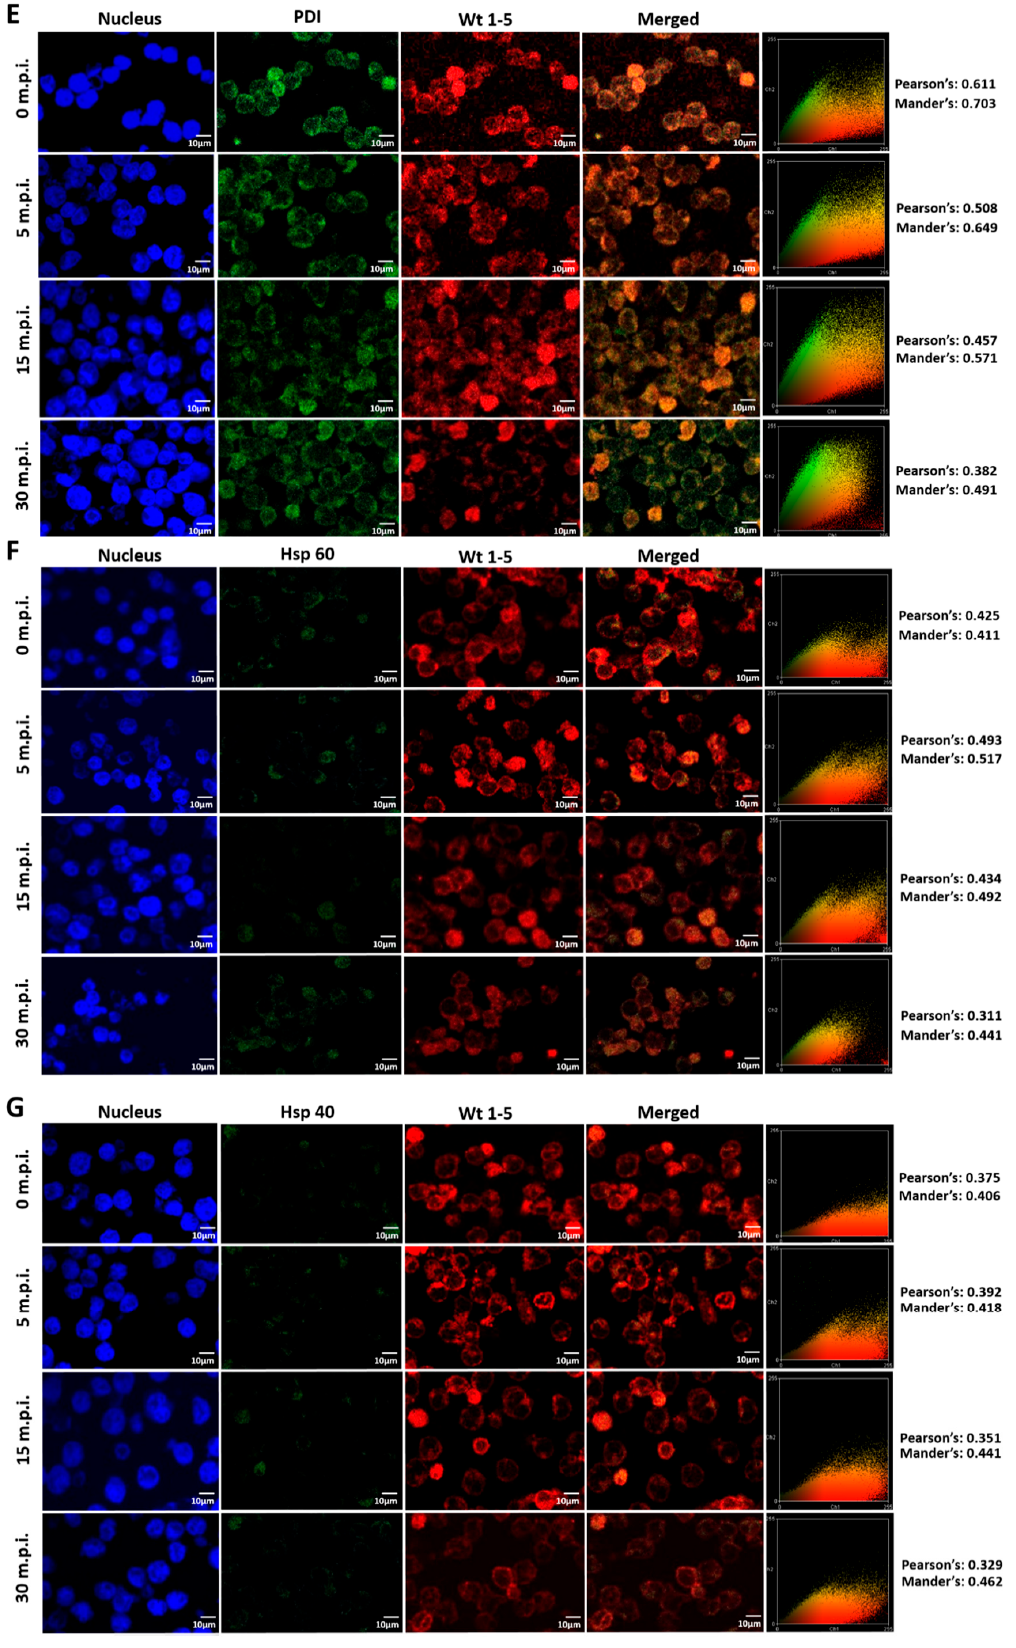
Figure 7. Colocalization of cellular proteins and Wt1-5 structural proteins. Reh cells that had been incubated for 15 min at 4 ◦ C were inoculated with trypsin-activated Wt1-5 and collected at 0, 5, 15